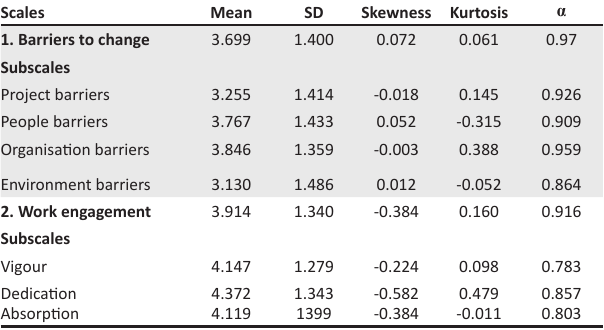
TABLE 2: Descriptive statistics and alpha coefficients for t he Barriers to Change Questionnaire and the Utrecht Work Engagement Scale.